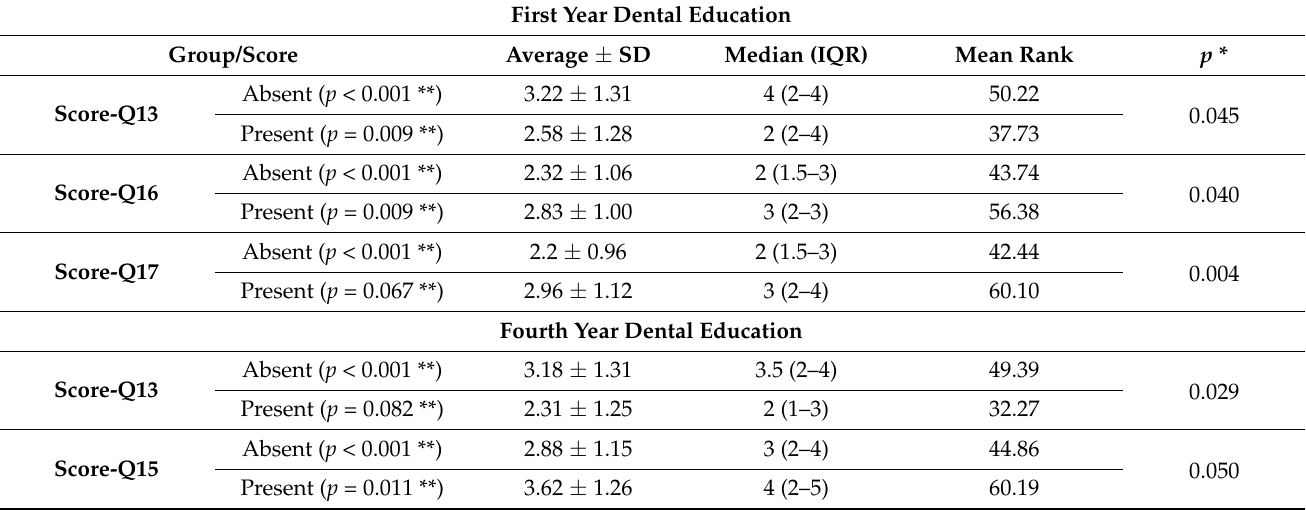
Table 4. Comparison of analysed scores according to the year of